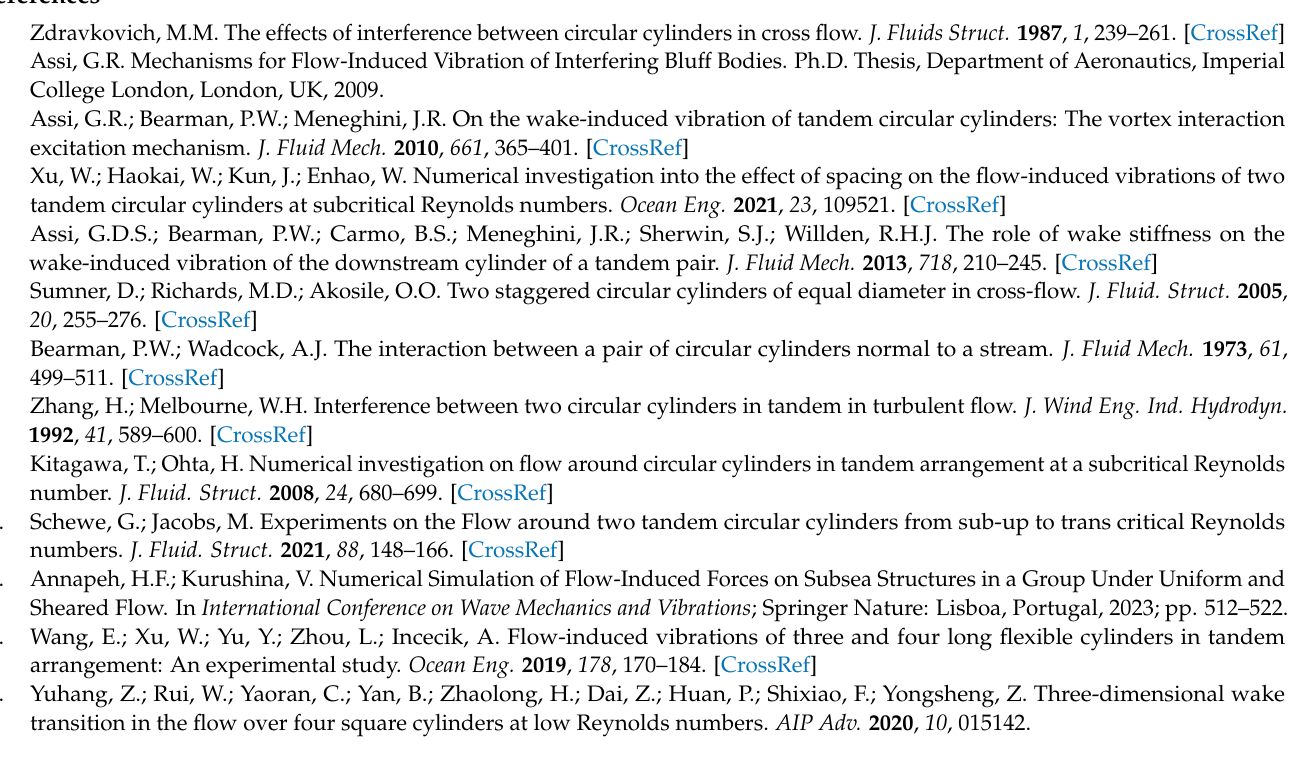
Figure A20. Fluid force coefficients for cylinder 6 immersed in planar sheared flow: ( a ) time history of the fluctuating drag coefficient; ( b ) time history of the lift coefficient; ( c ) the fluctuating drag co–efficient FFT; ( d ) the lift coefficient FFT.